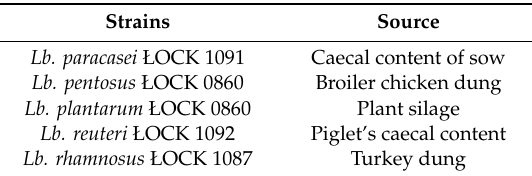
Table 1. Probiotic